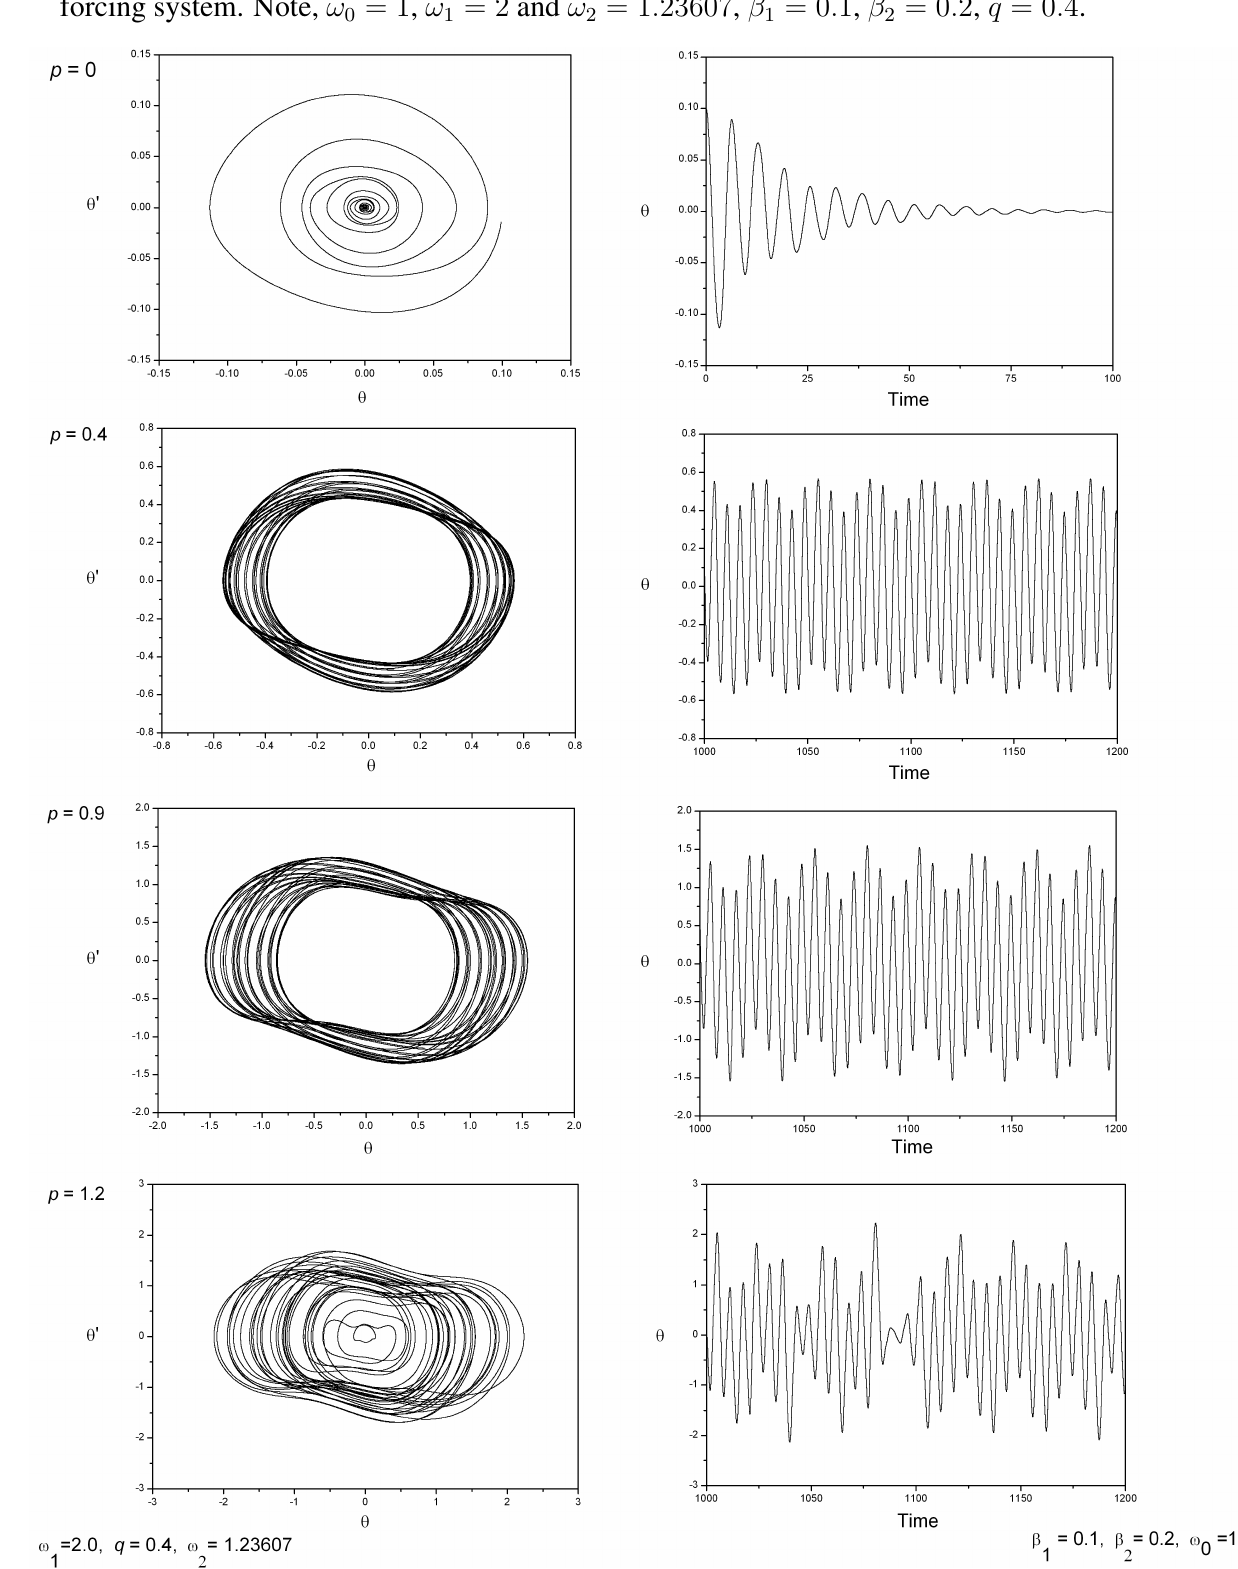
Figure 7. Phase portraits and time series at the stated forcing amplitude for the quasiperiodic forcing system. Note, ω